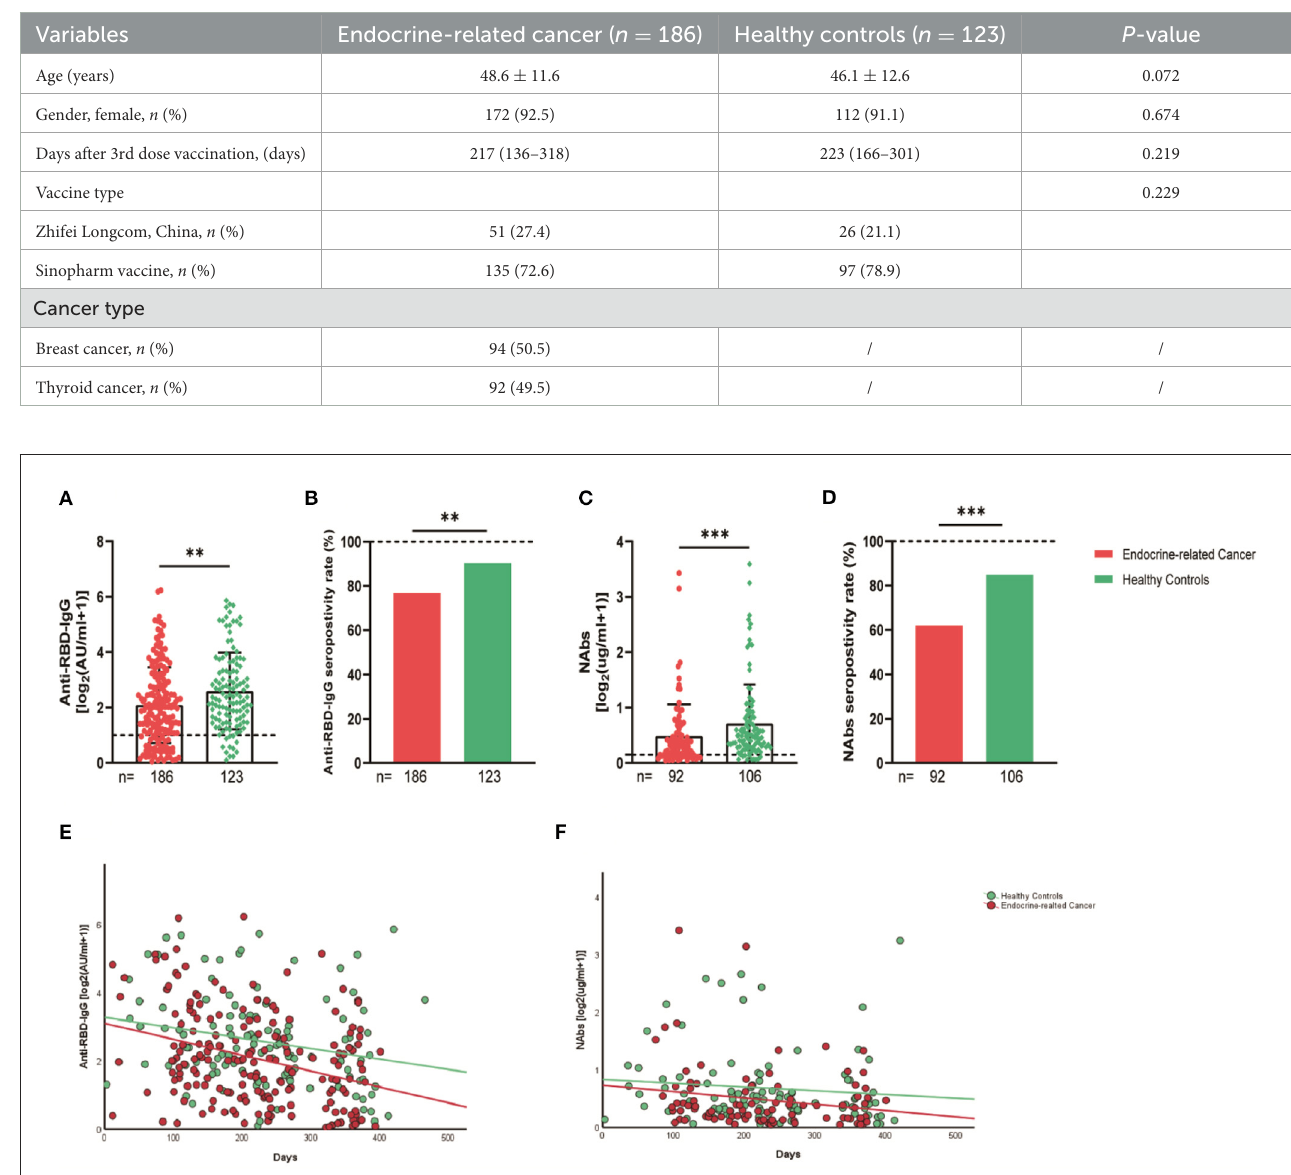
FIGURE2 Antibody response to SARS-CoV-2 vaccine in patients with endocrine-related cancer and healthy controls. The titers and seropositivity rates of anti-RBD-IgG (A, B) and Nabs (C, D) in the sera of cancer patients and healthy individuals were measured. Anti-RBD-IgG (E) and NAbs (F) potencies were measured separately according to different days after immunization. Trend lines were generated using a single linear model fit. Error bars represent the median (IQR) (** P < 0.01, *** P < 0.001). Nabs, neutralizing antibodies; IQR, interquartile range; RBD, receptor binding domain.